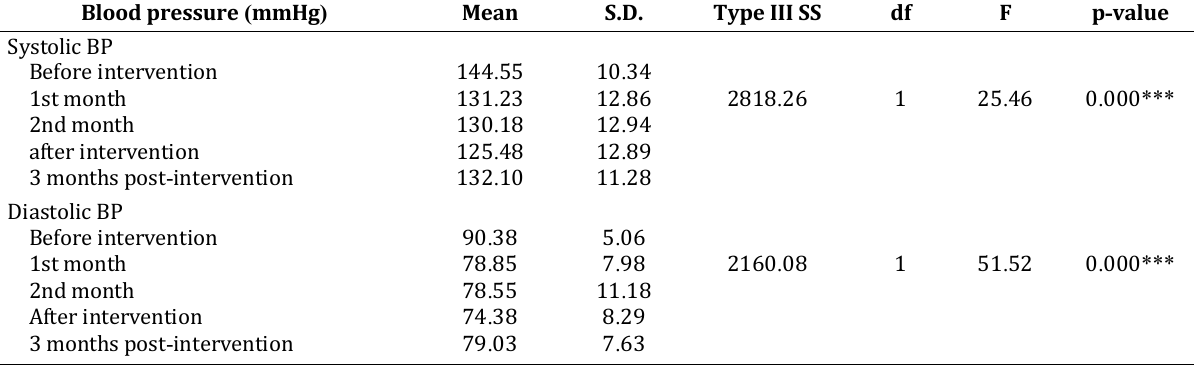
Table 2. Systolic Blood Pressure and Diastolic Blood Pressure of People with Uncontrolled HT Before, First Month, Second Month, After Intervention, and Three Months Post-Intervention (N=30) Blood pressure ( mmHg )